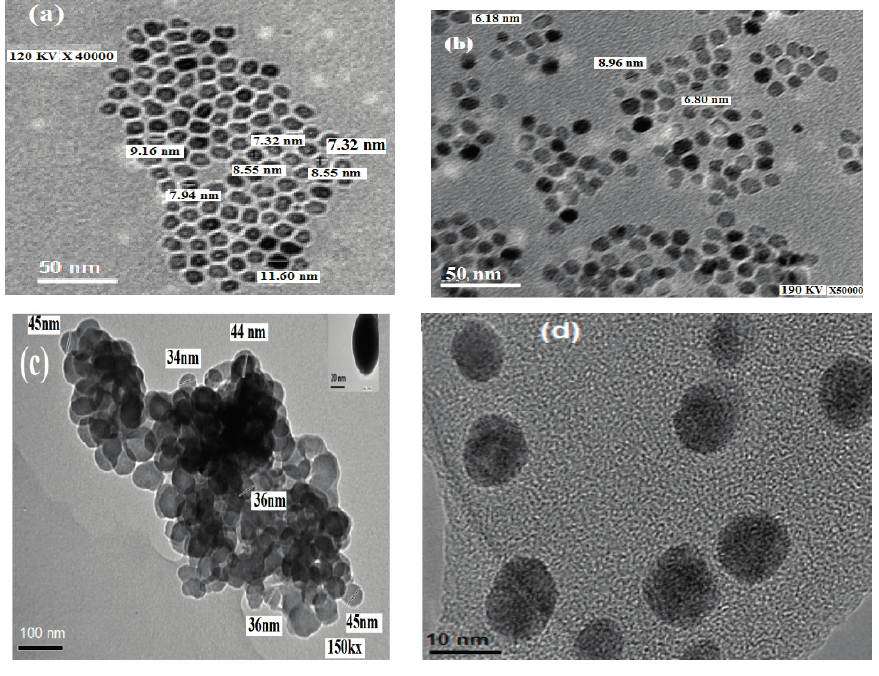
Figure 4. TEM micrographs of the prepared magnetite ( a ) absence of iodine; ( b ) presence of iodine; ( c ) presence of myrrh; and ( d ) presence of myrrh and